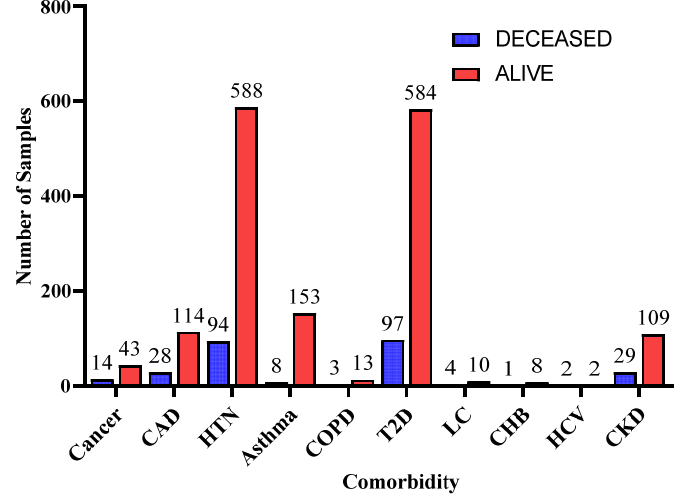
Figure 5. Distribution of comorbidity according to patients’ vital status.